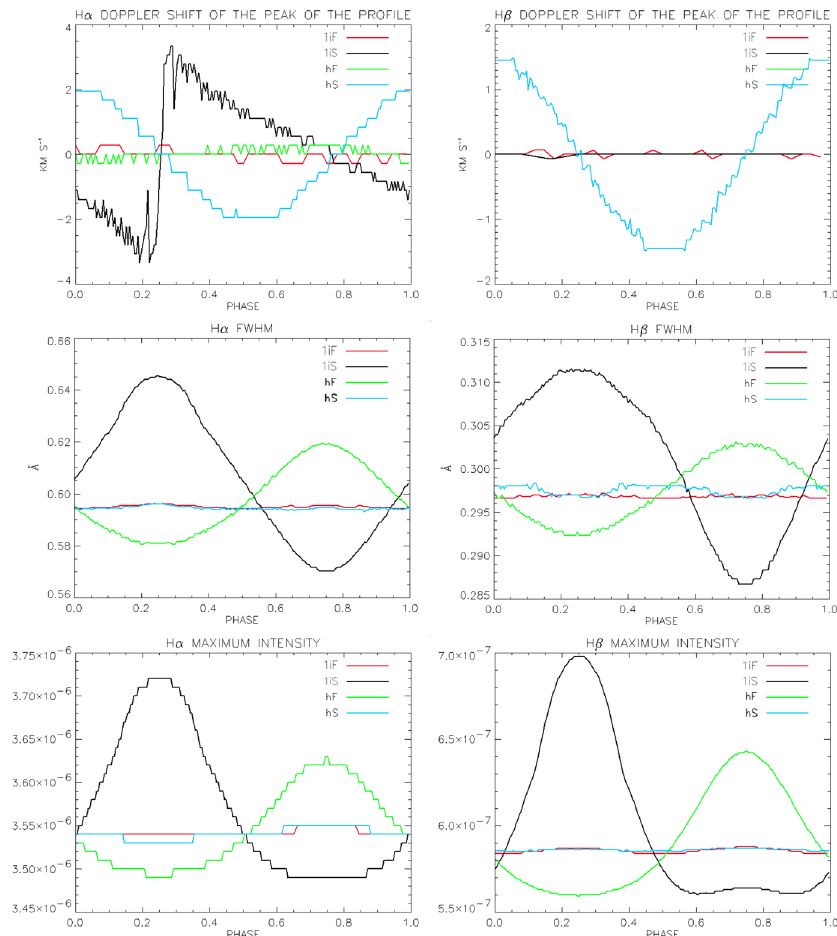
Fig. 62 MHD plus radiative transfer model: temporal variation of the spectral line parameters of the H α (left) and H β (right) lines for the magnetoacoustic hS, hF, 1iS and 1iF modes (see text for an explanation of these acronyms). From top to bottom: Doppler velocity, full width at half maximum (FWHM) and line intensity. Image reproduced with permission from Zapiór et al. (2016), copyright by